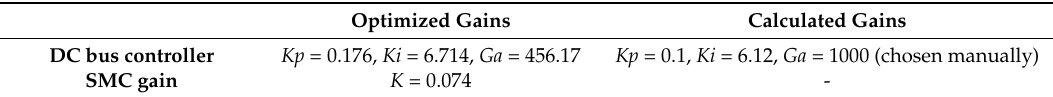
Table 3. Optimized and calculated gains.